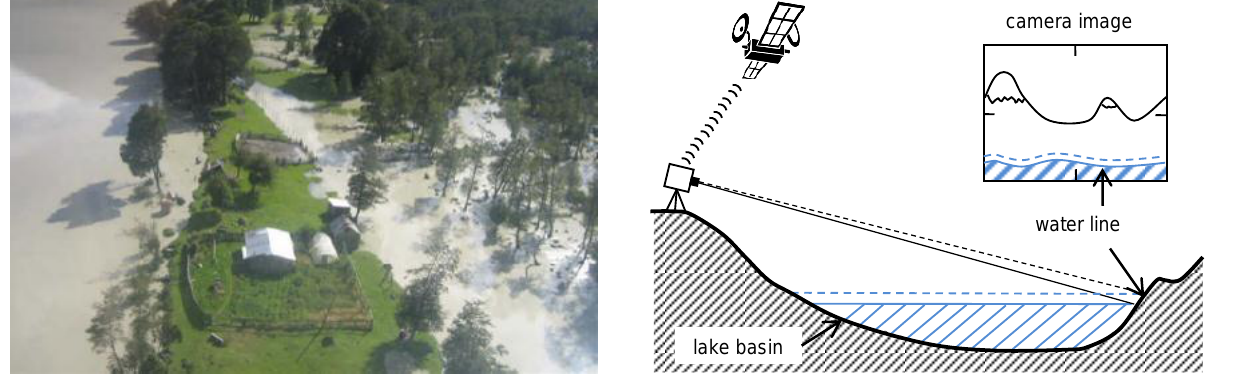
Figure 4. Concept on an image based warning system. The main component is a camera, which observes the water